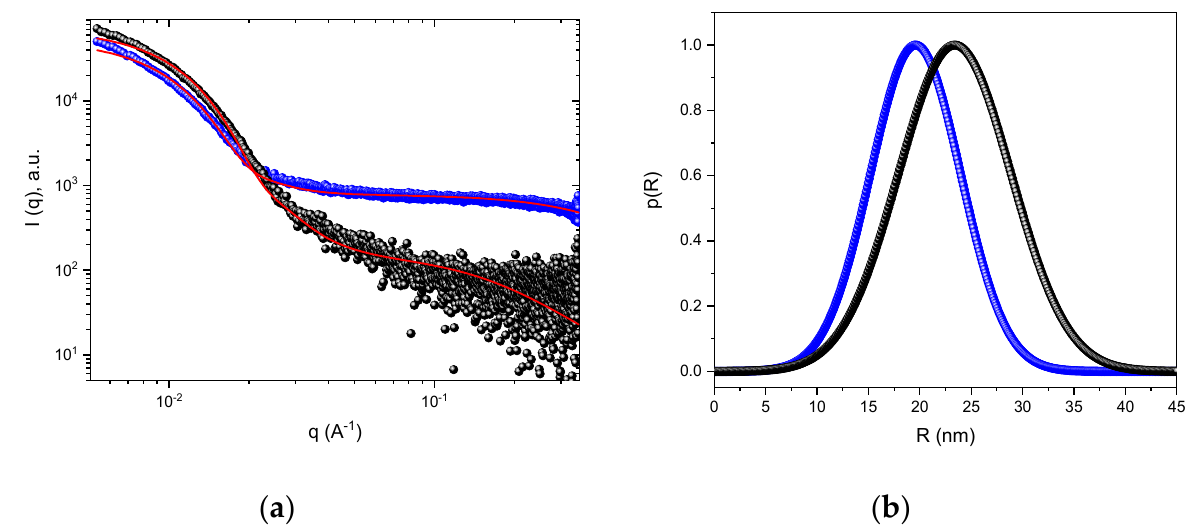
Figure 4. SAXS patterns of NPs after 48 h of incubation at pH ~7.4 ( • ) and pH ~5.0 ( • ) along to the fitting results—olid red lines ( a ) and the respective p(R) vs. R profiles ( b ).